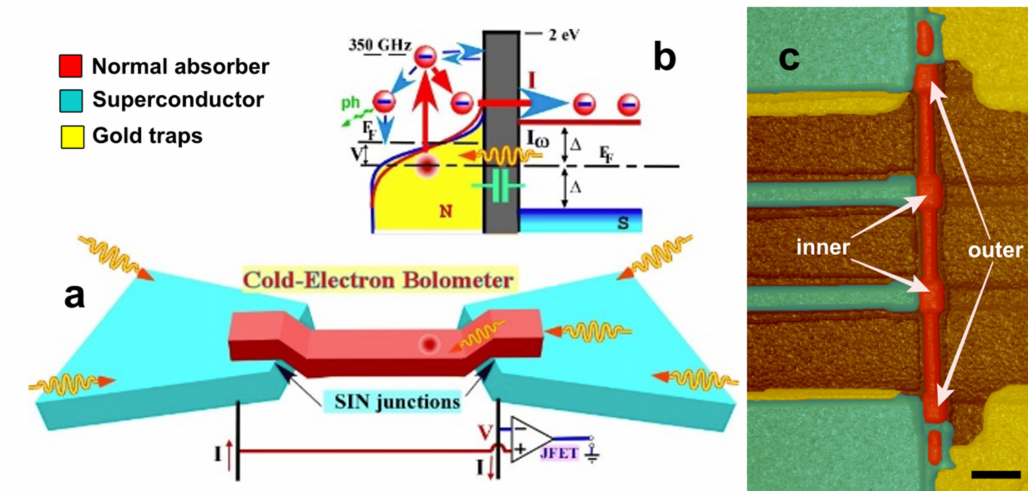
Figure 1. ( a ) Principle of the CEB operation. The incident electromagnetic radiation is collected and subsequently focused by the antenna on the absorber, which then goes through the SIN tunnel junctions. ( b ) The energy diagram shows the main heat flow processes: absorption of a photon by an electron in a normal absorber, thermalization of electrons, and tunneling of hot electrons. The read-out scheme is shown in a current-bias mode. ( c ) AFM image of the CEB showing the normal metal absorber (red), the superconductor (cyan), and the gold electrode, which also serve as the electron traps. The inner and outer SIN tunnel junctions are also shown. The black scale bar on the lower right corner corresponds to a dimension of 1 µ